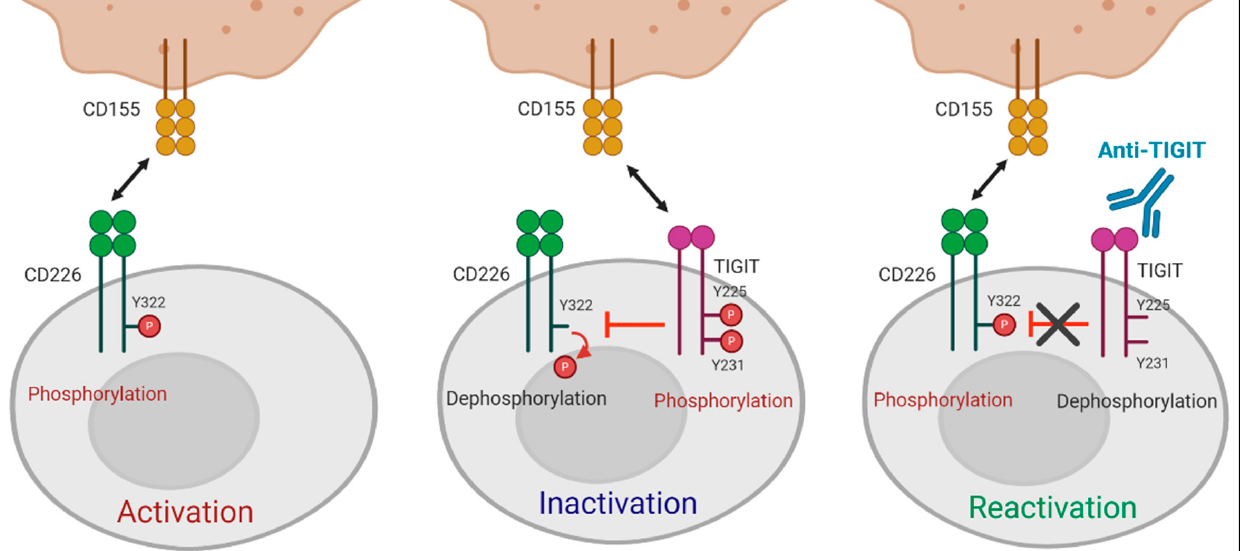
Figure 2. Role of CD226 in anti-TIGIT immunotherapy. TIGIT has a direct effect on intracellular regulation of CD226 activation in response to PVR binding. ( Left ) When TIGIT expression is absent or low, engagement of CD226 with PVR induces the phosphorylation of tyrosine 322 (Y322) on CD226, which leads to the activation of intracellular signaling cascades. ( Middle ) PVR preferentially binds to upregulated TIGIT over CD226. Upon interaction with PVR, the cytoplasmic tail of TIGIT is phosphorylated. This PVR-induced TIGIT phosphorylation inhibits T cell responses by promoting CD226 dephosphorylation. ( Right ) TIGIT blockade suppresses PVR-induced TIGIT phosphorylation and restores the impaired Y322 phosphorylation of CD226, thereby leading to T cell activation.